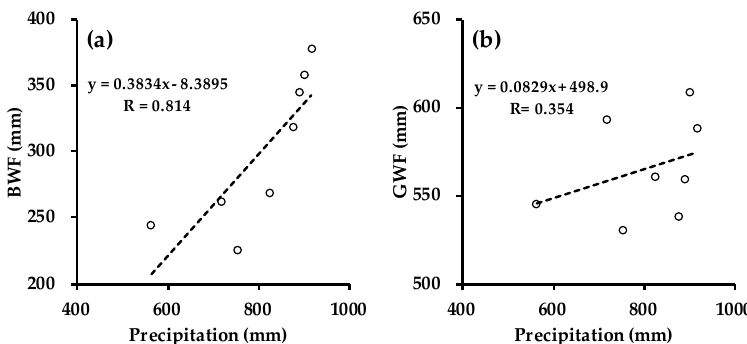
Figure 13. The relationship between precipitation and water flow in the ELB during 2009 to 2016: ( a ) precipitation vs. BWF; ( b ) precipitation vs. GWF.